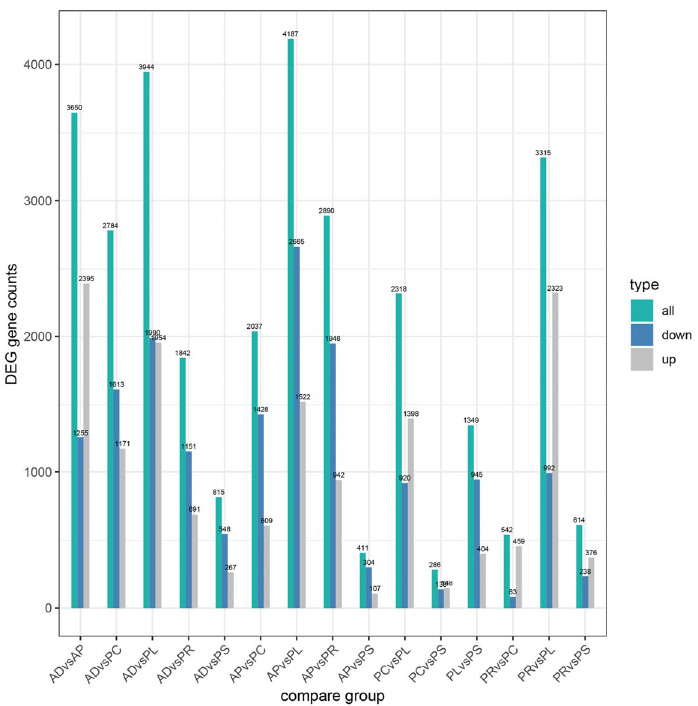
Figure 4. Numbers of upregulated and downregulated DEGs of different hosts by pairwise comparisons.